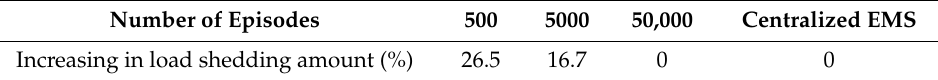
Figure 10. SoC of CBESS based on the Q-table with different episodes. Table 4. Increasing load shedding amount with a different number of episodes and centralized EMS.